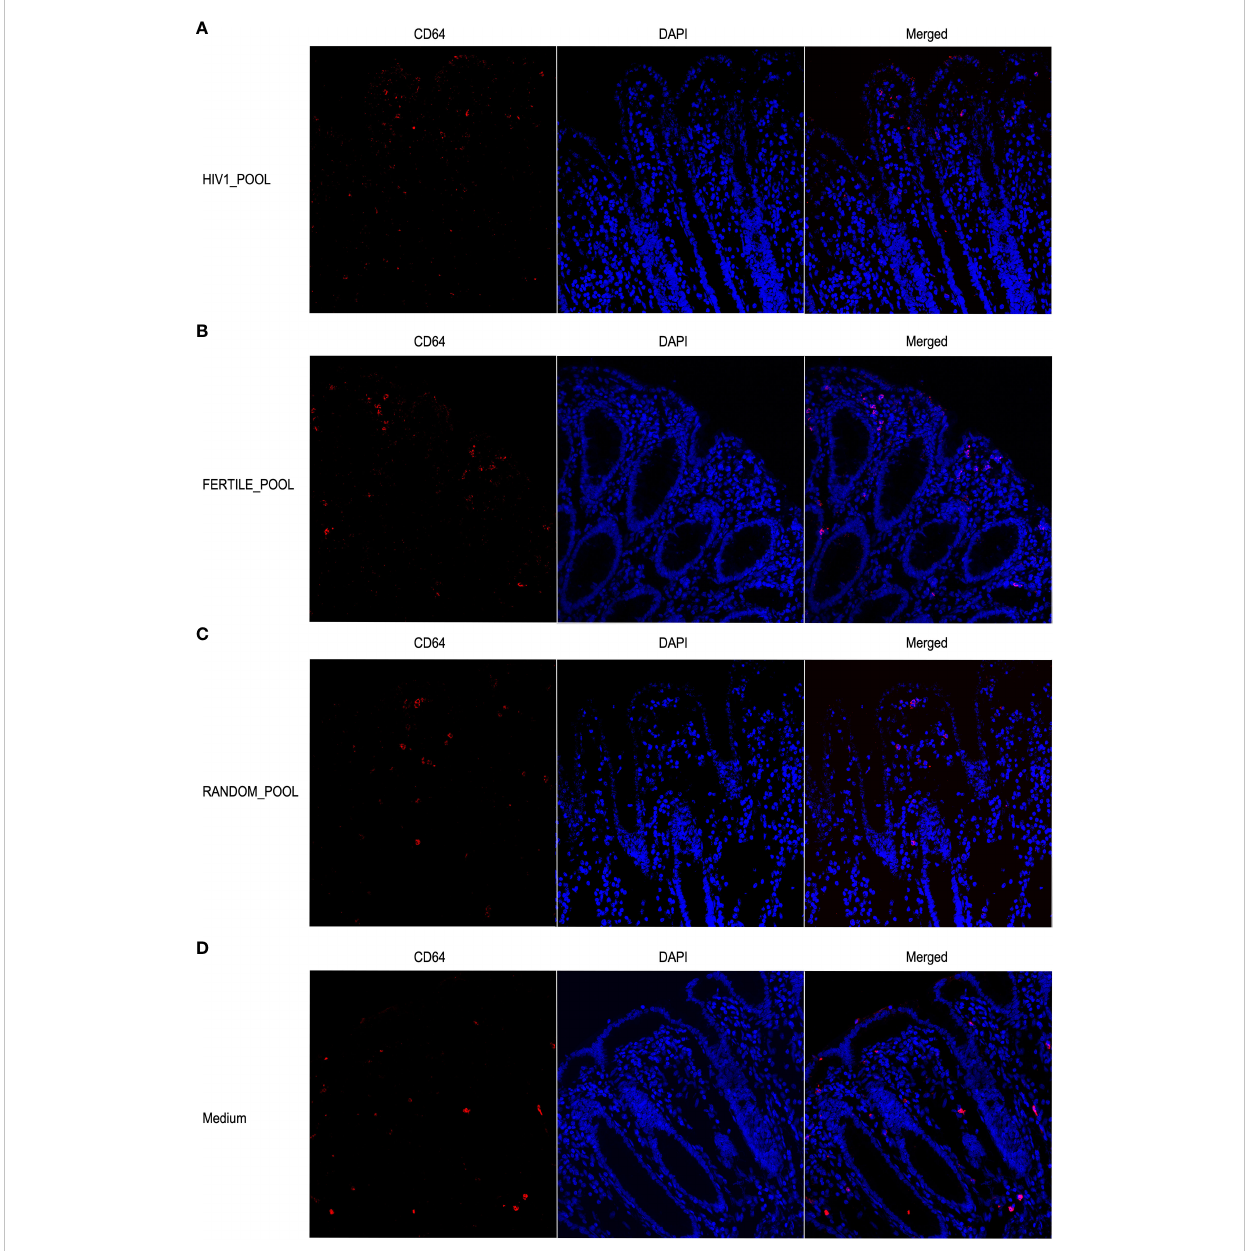
FIGURE 7 Stimulation with HSP does not induce redistribution of CD64+ MNP cells. Representative images of CD64+ positive cells show no differences in the distribution within the colonic mucosa stimulated with HSP pooled from HIV infected panel (A) , fertile panel (B) , randomly selected donors panel (C) or medium control panel (D) . Cells were stained with the mouse anti human CD64 mAb followed by Alexa Fluor 546-conjugated goat anti- mouse IgG1 antibody (red). DAPI fl uorescence probe was used to detect the nucleus